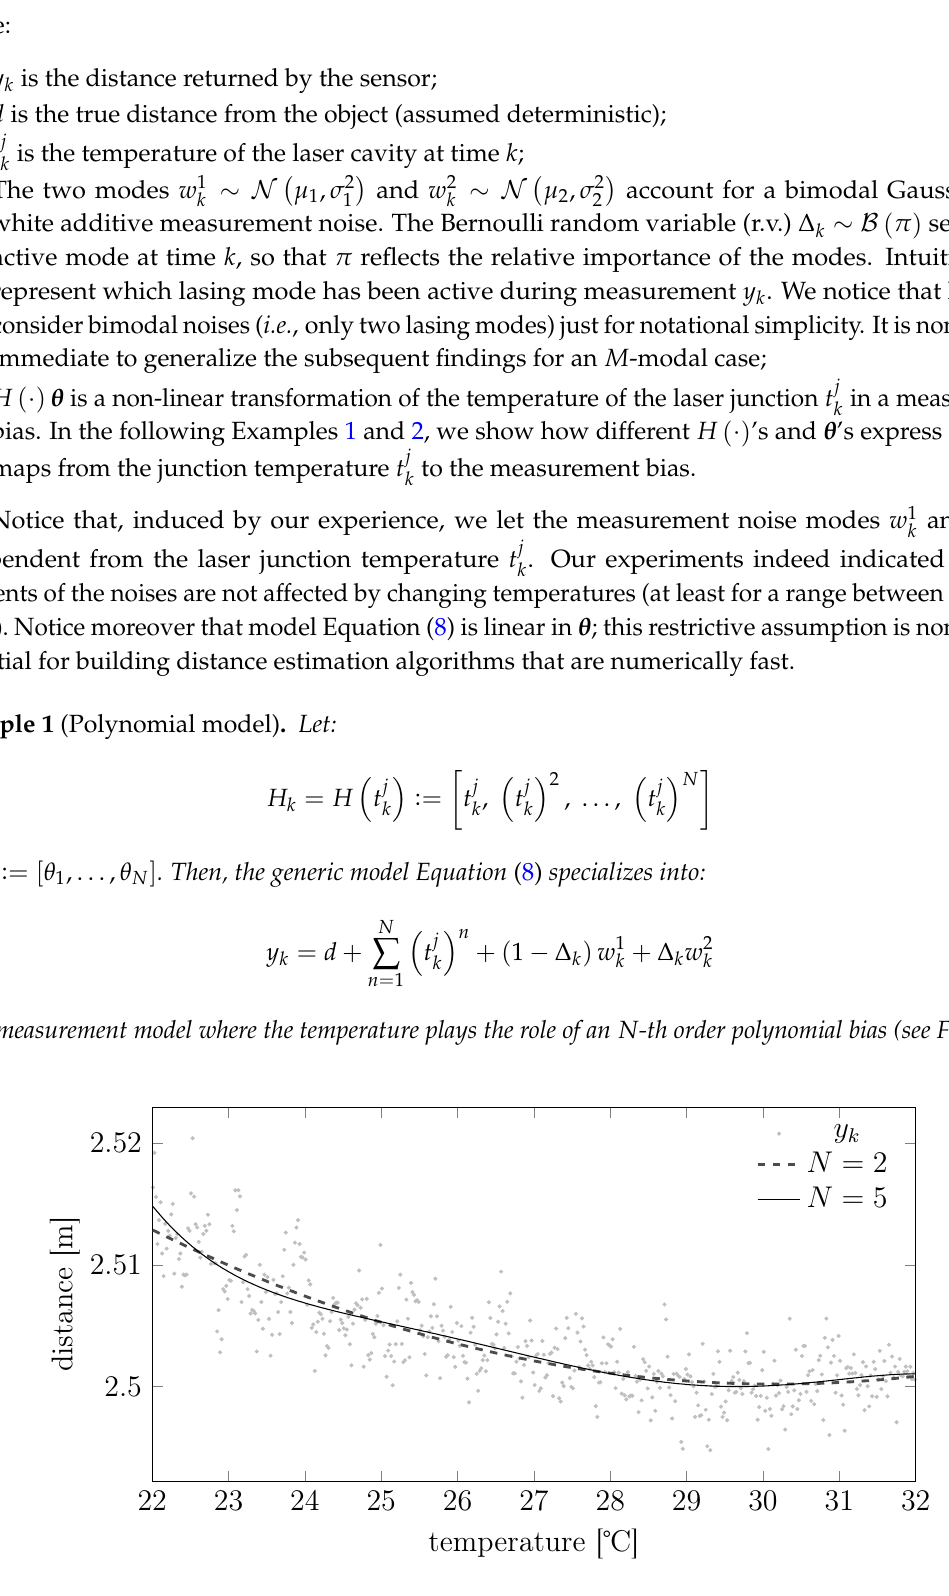
Figure 6. Potential temperature-bias dependencies for the polynomial model of Example 1.